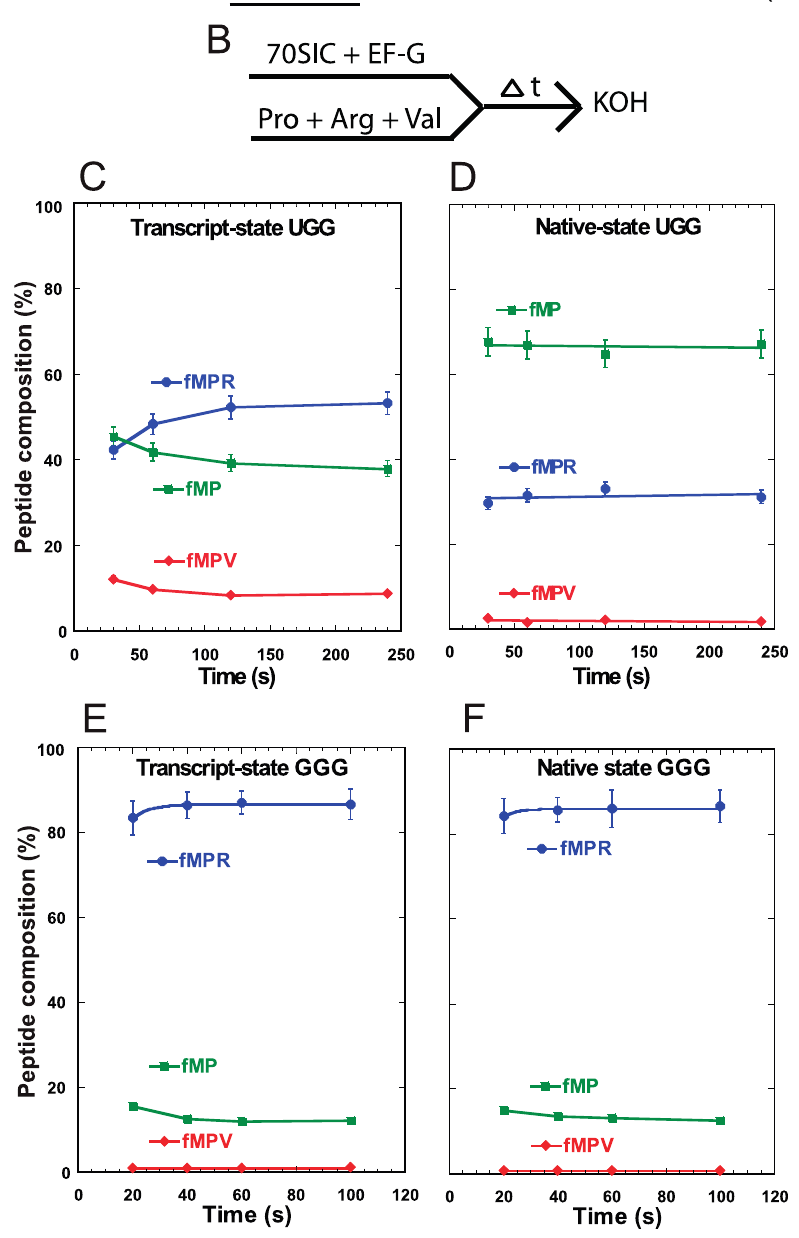
Figure 3. Analysis of forward +1 frameshifts of tRNA Pro during translocation into the P-site. ( A ) The template mRNA sequence, showing the 5 ʹ -Shine Dalgarno sequence (underlined), the AUG start codon (italic), and the slippery CCC-C sequence immediately following the start codon; ( B ) The reaction scheme for the conversion from fMP to tripeptides, starting with rapid mixing of a 70SIC with ternary complexes of tRNA Pro , tRNA Arg , and tRNA Val , in the presence of EF-G. The reaction was quenched over time by KOH. The changes in the peptide composition over time for the substrate fMP, the 0-frame product fMPR, and the +1-frame fMPV were monitored for ( C ) the transcript-state of the UGG isoacceptor of tRNA Pro ; ( D ) the native-state of the UGG isoacceptor; ( E ) the transcript-state of the GGG isoacceptor; and ( F ) the native-state of the GGG isoacceptor. Each data point is the average of 3 independent